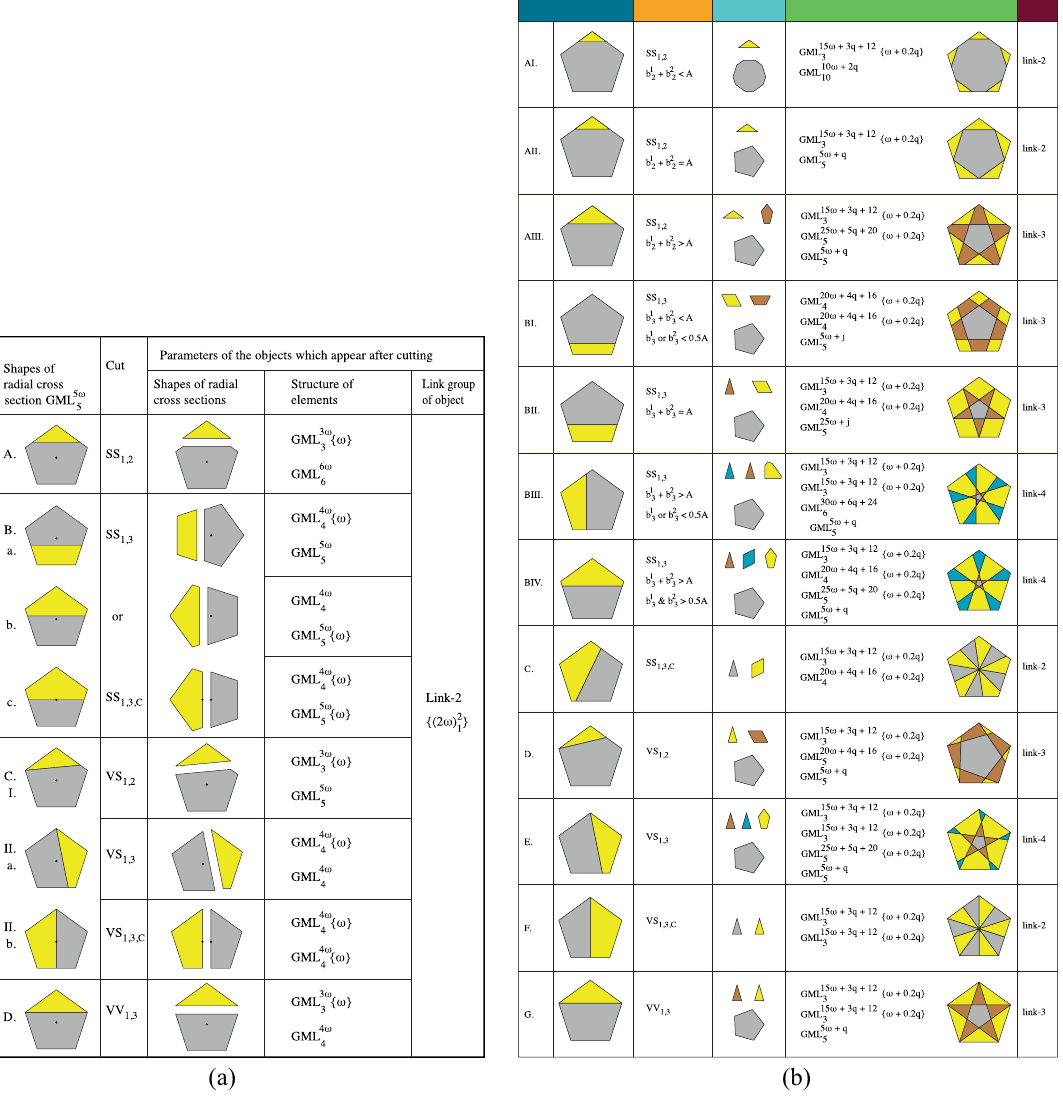
Figure 16. Cutting (a) GML 5 x objects are given in different